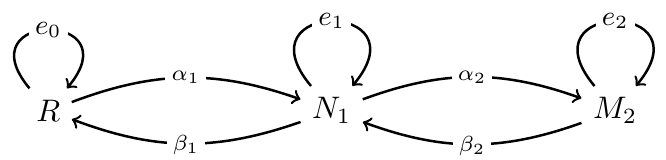
Figure 7. The proposed NCCR for R = C [ x; y; z; t ] = (5.1). N corresponds to a physical SU(2 N ) group, whereas M 2 (cid:17) coker is rank-one and corresponds to a physical SU( N )